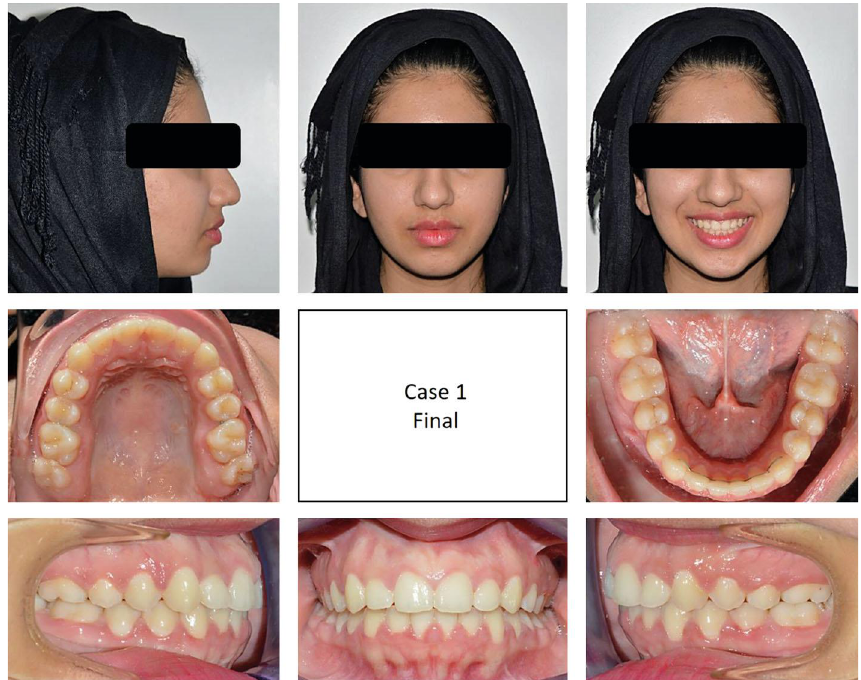
Figure 3: Posttreatment extraoral and intraoral photographs of the patient.